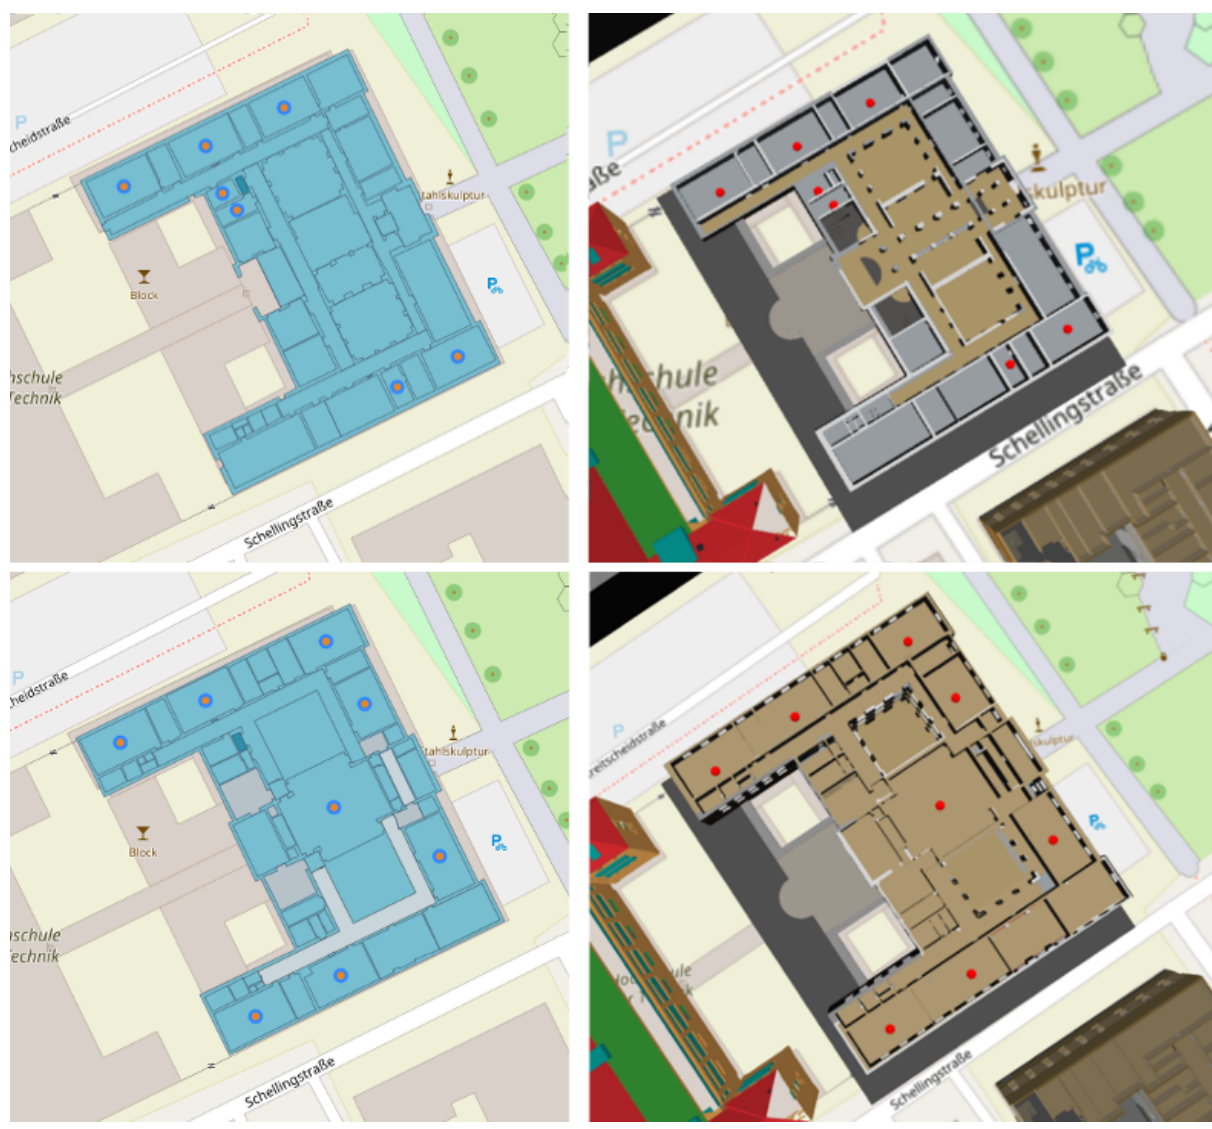
Figure 5. Sensors’ spatial attribute visualization on the ground floor (top) and second floor (bottom) of the test building in 2D (left) and 3D (right) platforms. Each circle on the map, or each sphere in the 3D model, represents a sensor’s location. Base Map c (cid:13) OpenStreetMap